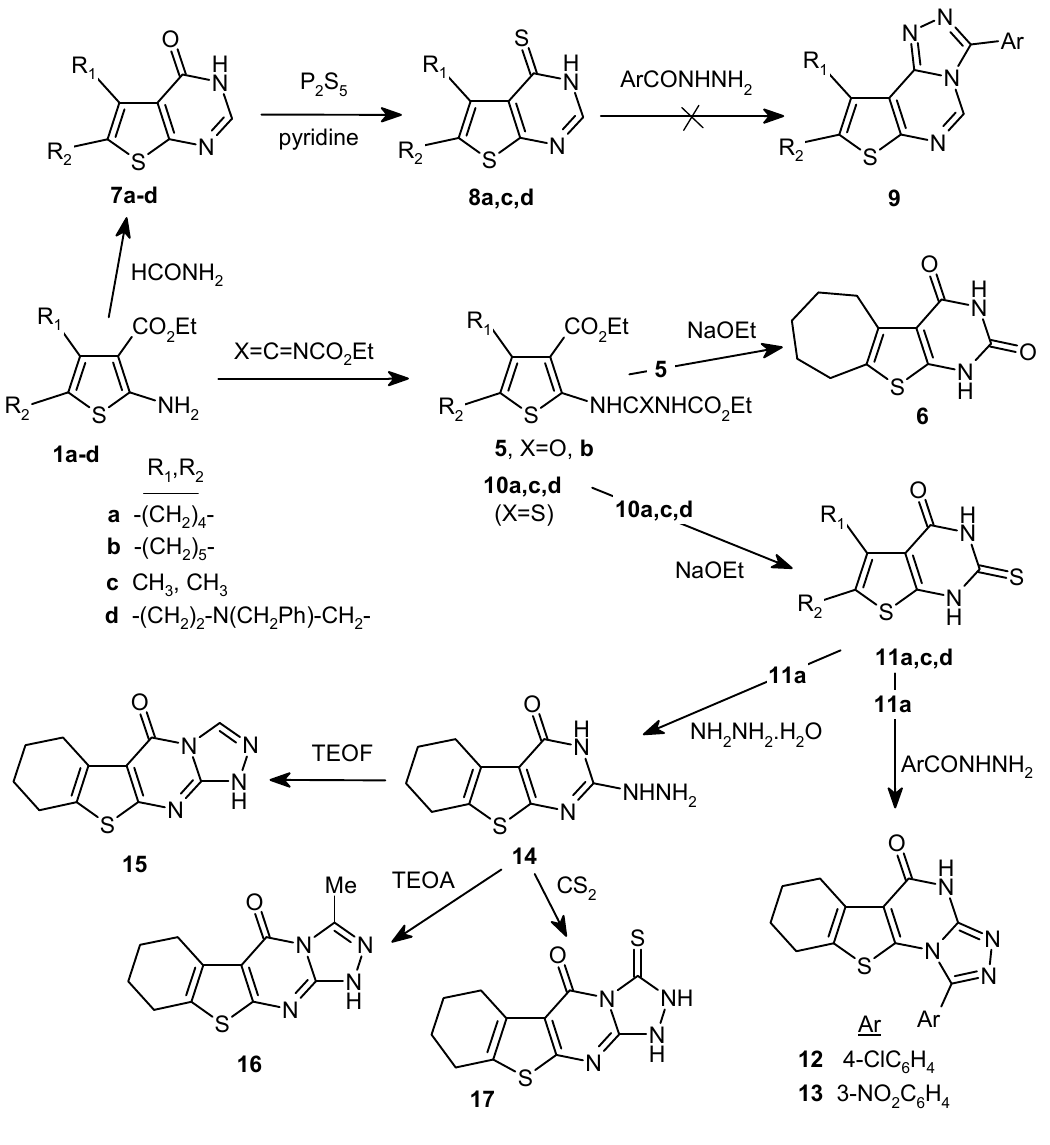
Figure 2. Selected HMBC spectrum of 13